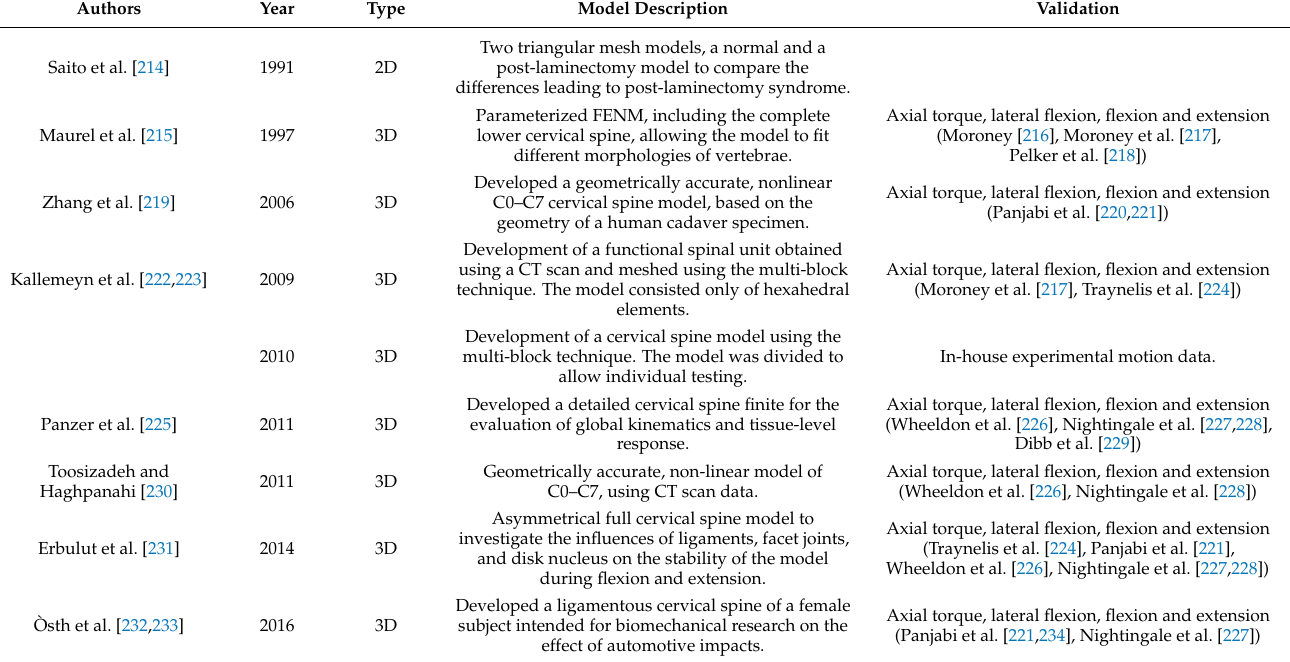
Table 2. Literature review on prominent Finite Element neck